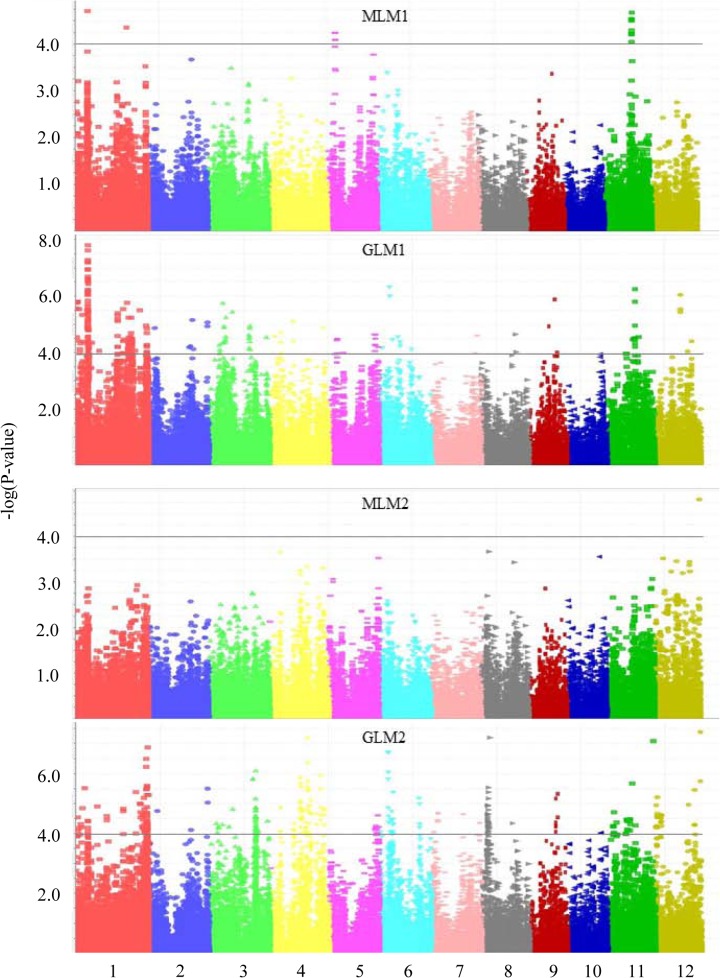
Manhattan plots for PUE (total biomass/total P) based on fixed (GLM) and mixed model (MLM) calculations in experiments 1 and 2.Colors indicate different chromosomes while the horizontal lines indicate a common significance level of P = 0.0001 [-log(P) = 4.0].